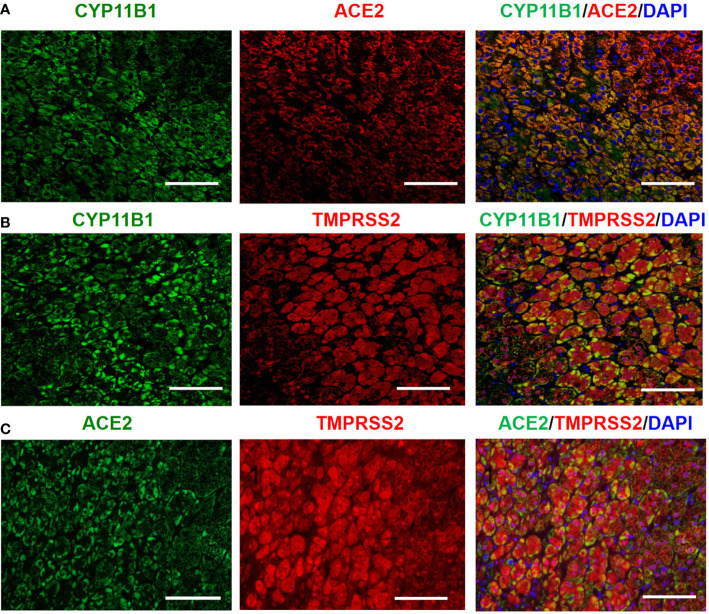
Double immunofluorescence staining demonstrates the colocalization of CYP11B1/ACE2 (A), CYP11B1/TMPRSS2 (B) and ACE2/TMPRSS2 (C) in human healthy adrenal tissues. Original magnification: ×200. Scale bars correspond to 50 μm.